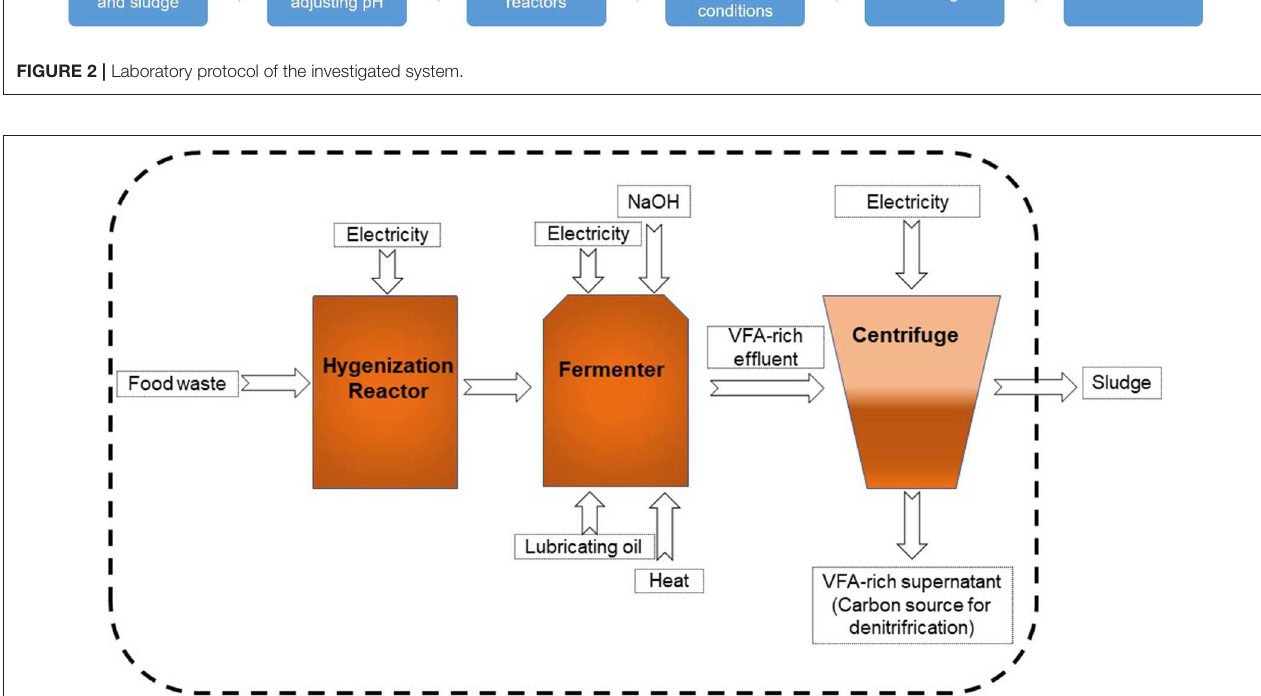
FIGURE 3 | Flow chart of the full scale